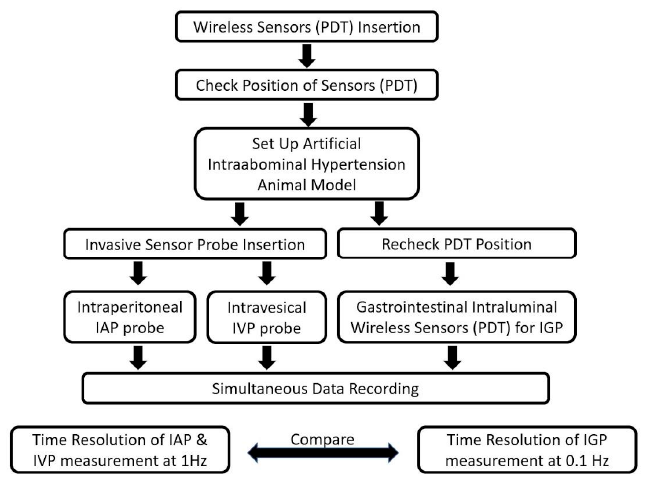
Figure 5. Flowchart of the in vivo study.